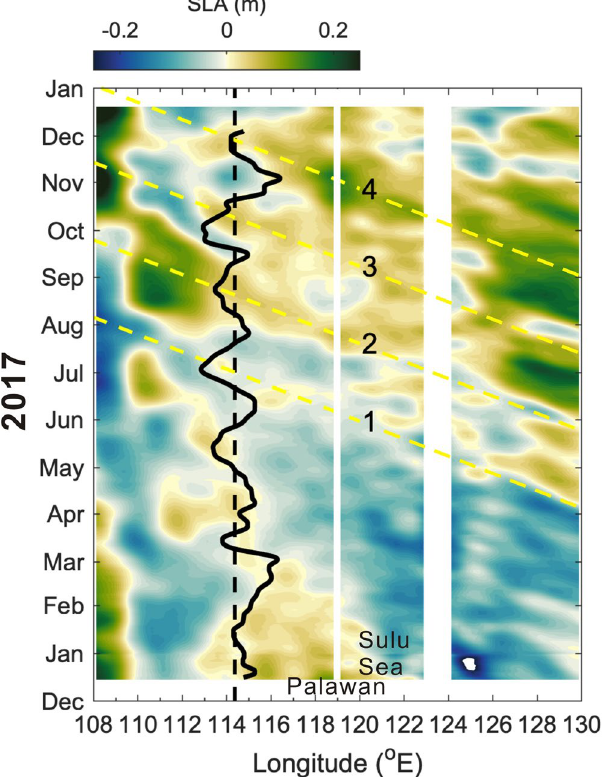
Figure 8. Time versus extended longitude SLA variation of Fig. 3a. Same as Fig. 3a but the longitude is extended to 130° E to include the tropical North Pacific east of the Philippine